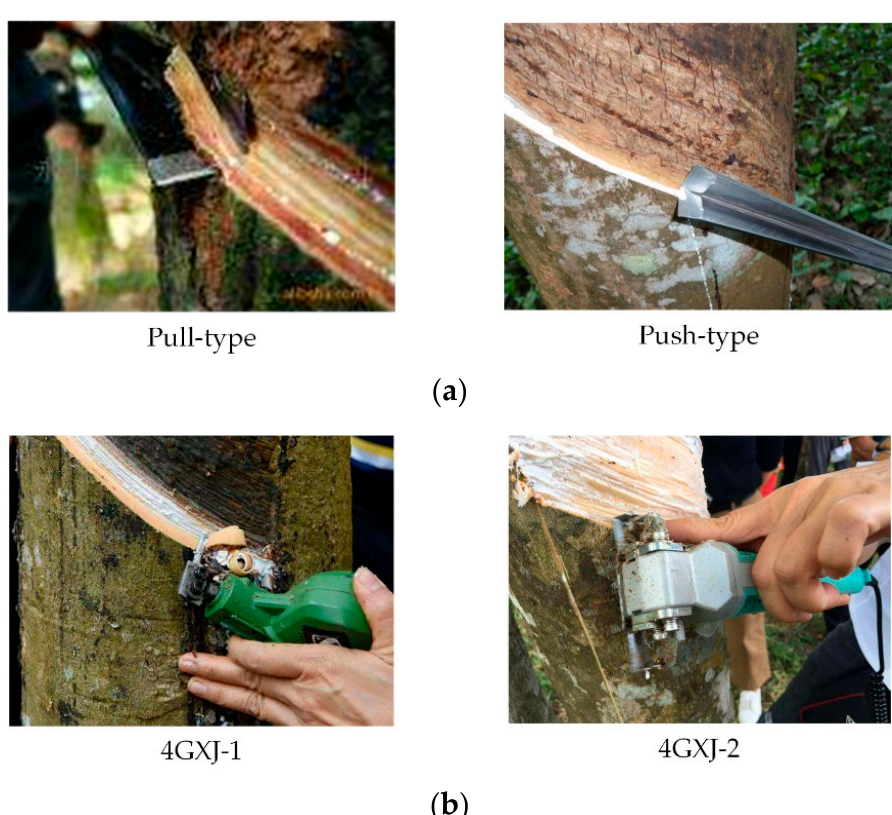
Figure 5. ( a ) Traditional tapping knife; ( b ) portable electrical tapping device.